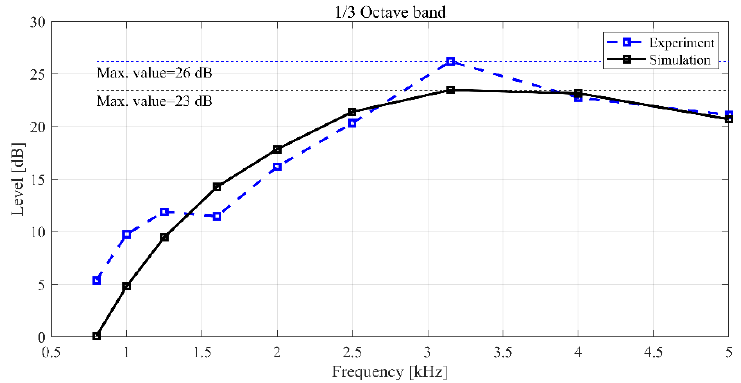
Figure 9. Comparison of experimental and simulation model of sound pressure level.